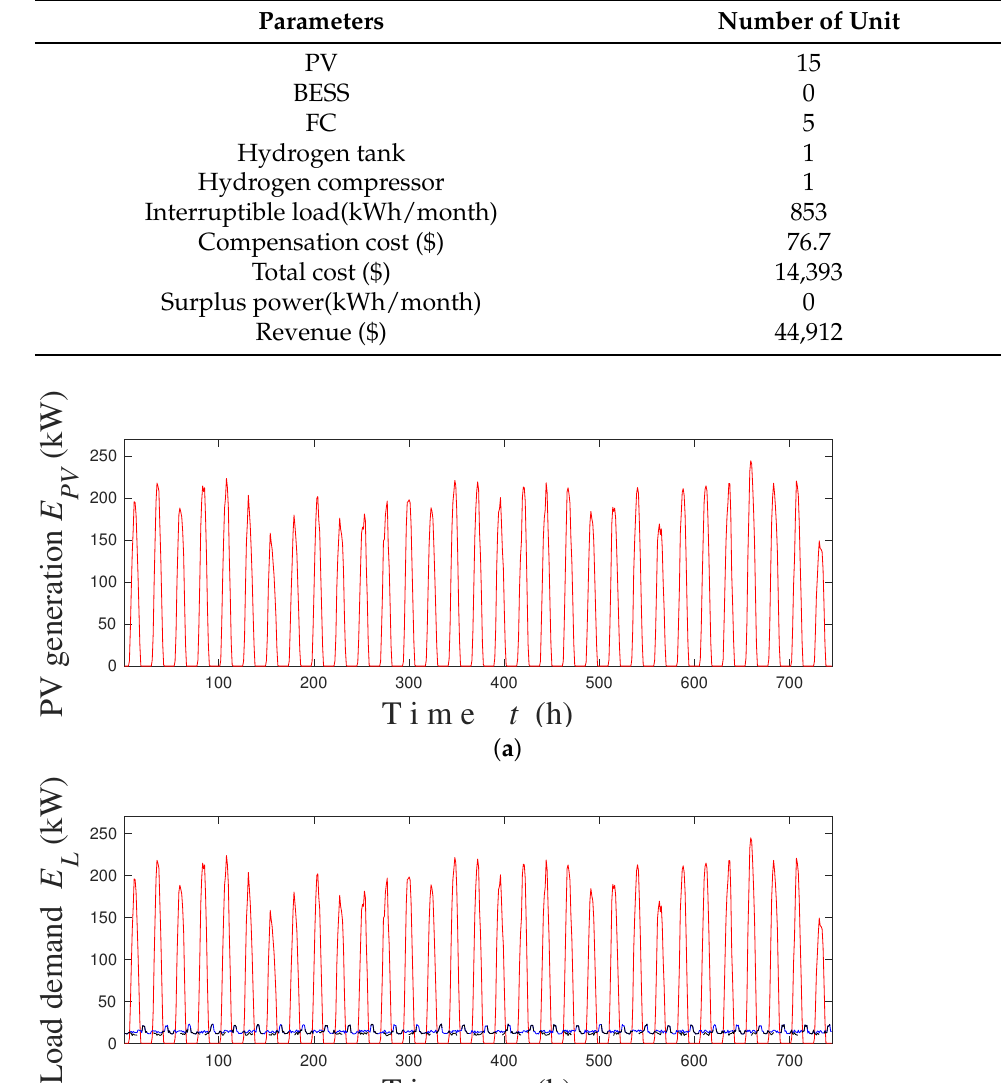
Table 15. Simulation results of case 4.